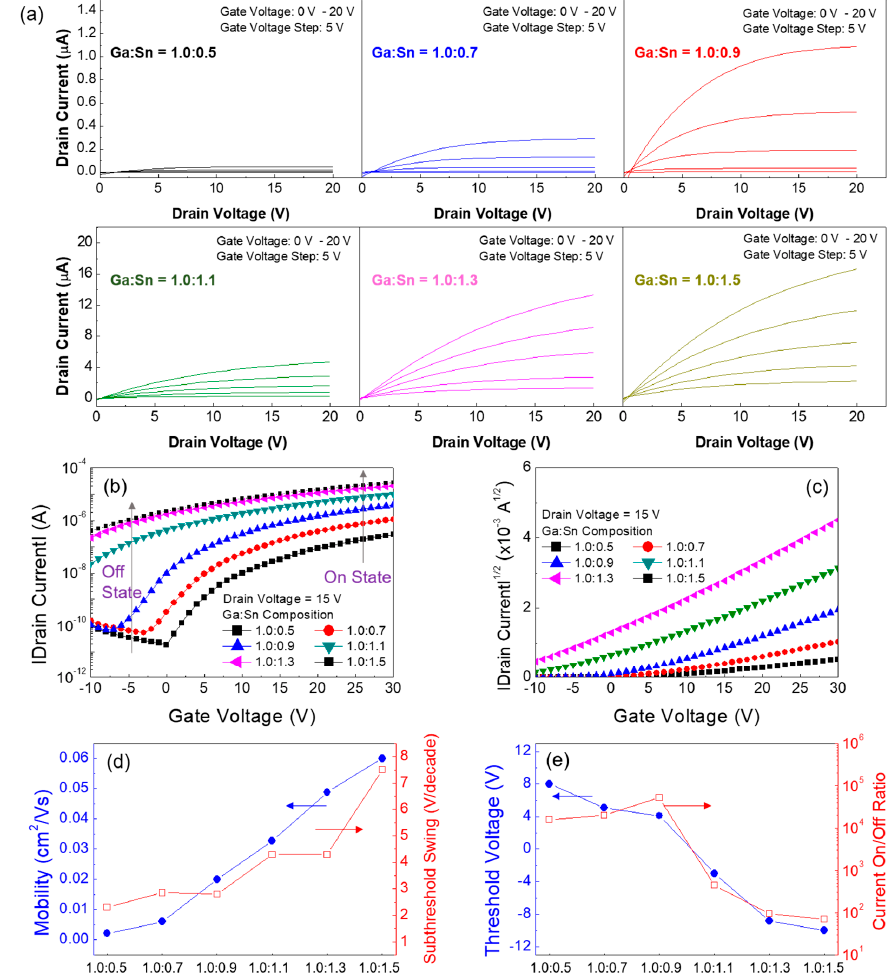
Figure 7. ( a ) Output characteristics of the Ga:Sn oxide TFTs. Transfer characteristic plots of ( b ) |drain current| versus gate voltage and ( c ) |drain current| 1/2 versus gate voltage. Variations in the TFT characteristics according to the Ga:Sn composition: ( d ) field-effect mobility and subthreshold swing versus Ga:Sn composition, and ( e ) threshold voltage and current on/off ratio versus Ga:Sn composition.